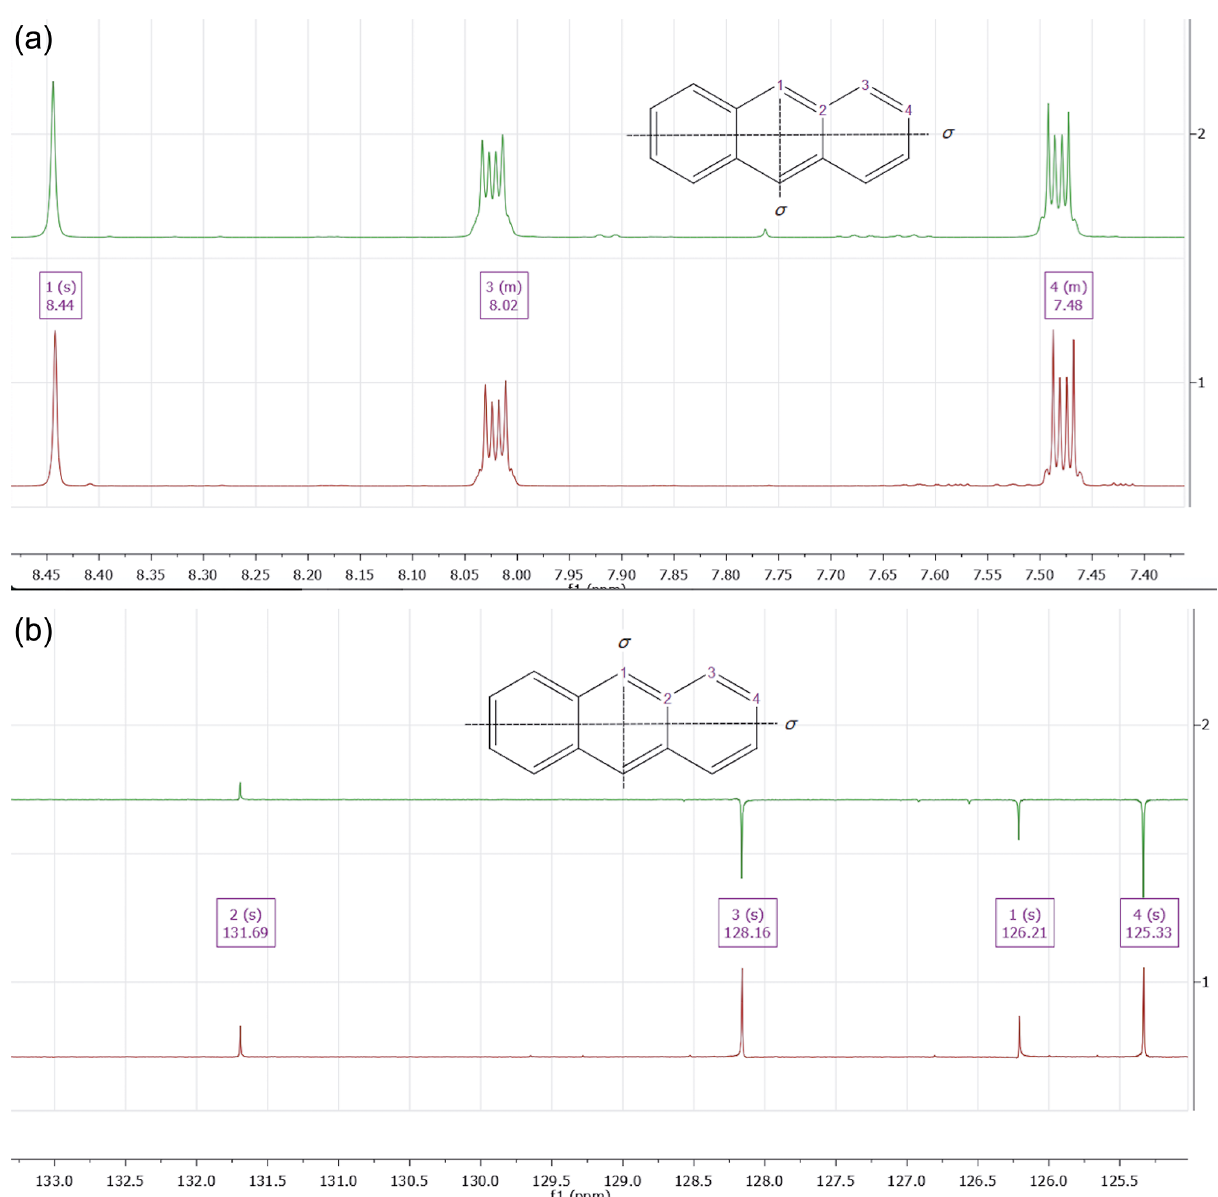
Figure 4. 1 H (a) and 13 C NMR spectrum (b) of a sample of freitalite (green colored) as well as an authentic sample of anthracene (red colored). The NMR spectra were recorded using the Varian spectrometers Gemini 2000 or Unity 500 in CDCl 3 ; residual un-deuterated solvent used for referencing, 20 ◦